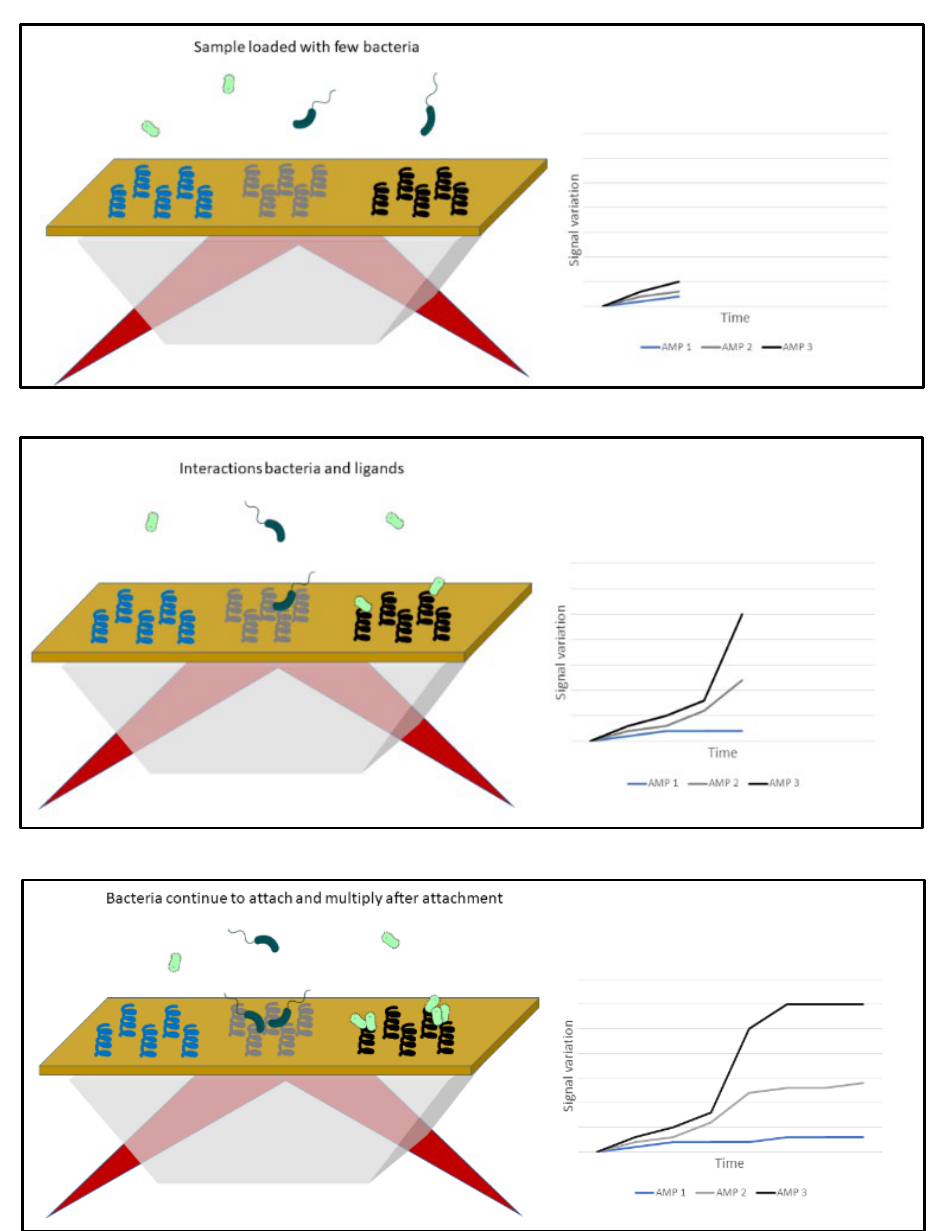
Figure 10. Principle of the method “Culture-Capture-Measurement” for the detection of bacteria by SPRi. The bacteria initially present in small numbers in the sample multiply and end up interacting with the AMPs placed on the surface provided that some have an affinity for them. These interactions are visualized either on the differential images where a difference of color intensity with respect to the initial levels is carried out, or on the kinetics of variation in reflectivity ( ∆ R) as a function of time. In this method, the analysis time is governed by the growth rate of the microorganism; the faster the growth, the sooner the detection threshold of the sensor can be reached. (Figure 10) The method has been validated on various strains of Salmonella, Listeria, Staphy- lococcus, and Escherichia